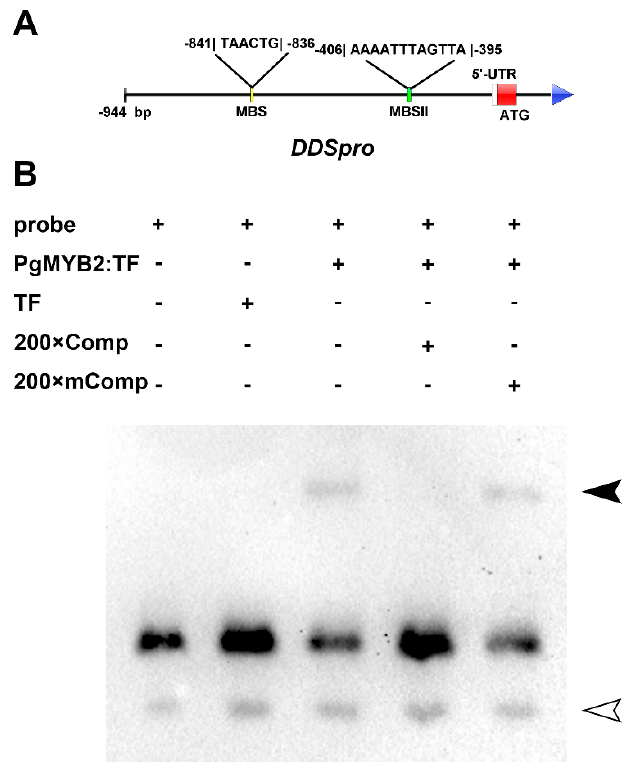
Figure 6. Binding assay of PgMYB2 to the MBSII. ( A ) The diagram shows the relative location of the MBS and MBSII in the region of DDSpro. ( B ) The fusion protein of PgMYB2 binds to the MBSII of DDSpro. The reaction system from left to right: biotin-labeled probe (containing MBSII site); labeled probe and trigger factor as negative control (TF, a kind of chaperonin); labeled probe and PgMYB2: TF protein; labeled probe, PgMYB2: TF protein and 200 × Comp (200 times unlabeled competitive probe); labeled probe, PgMYB2: TF protein and 200 × mComp (200 times unlabeled competitive mutant probe, the MBSII site was mutated). The protein-probe complexes were indicated with a solid arrow and the free probes were indicated with a hollow